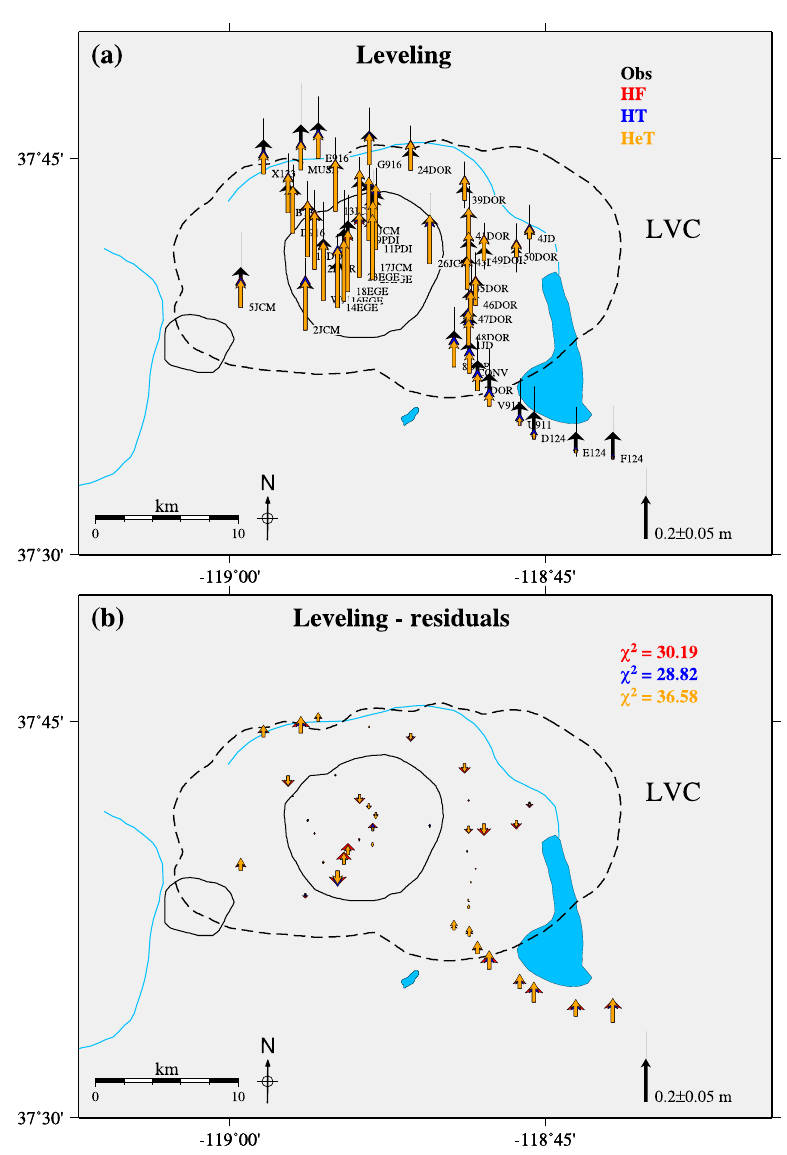
Figure 7. ( a ) Comparison between observed (black arrows with thin solid line as error) and modeled (colored arrows corresponding to different model configurations) uplift for the period 1985–1999. ( b ) Corresponding residuals between modeled and observed uplift. Obs: observations; HF: homogeneous flat crust; HT: homogeneous crust with topography; HeT: heterogeneous crust with topography. χ 2 values for each model are shown on top right.